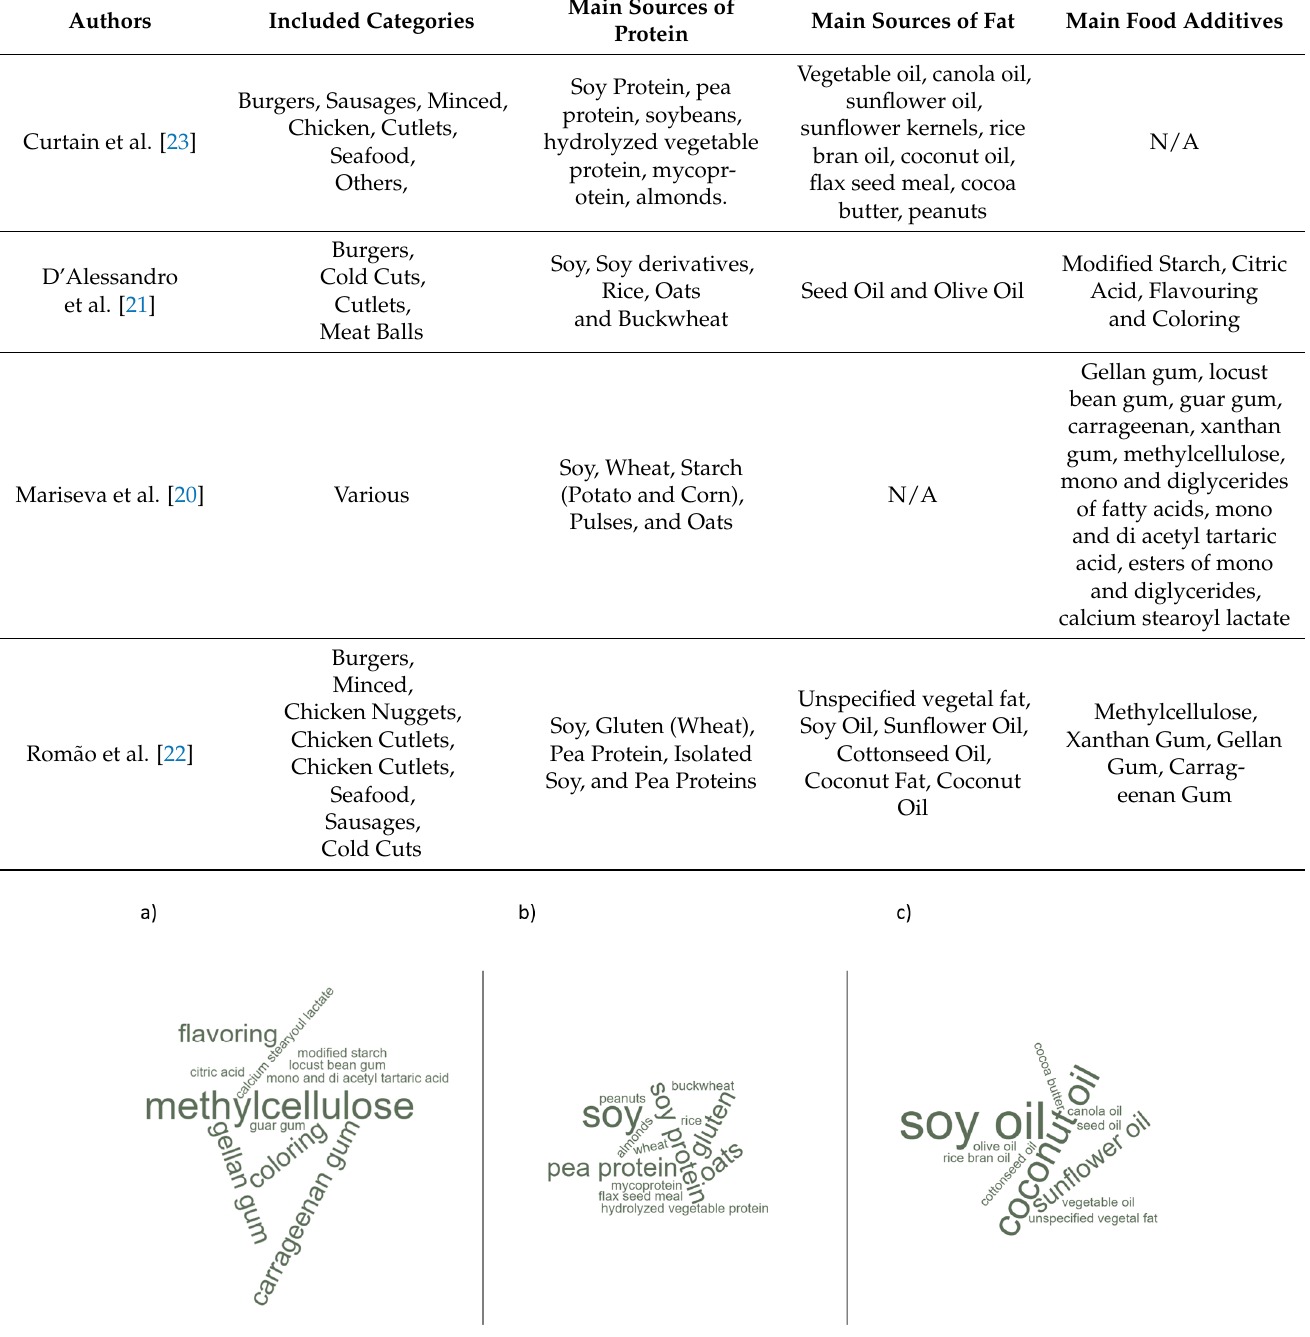
Figure 3. Word cloud generated with the frequencies of implemented ingredients in the included meat substitutes. Higher frequencies are represented with more prominent words in the cloud. ( a ) Food additives; ( b ) Protein sources; ( c ) Fat Sources.